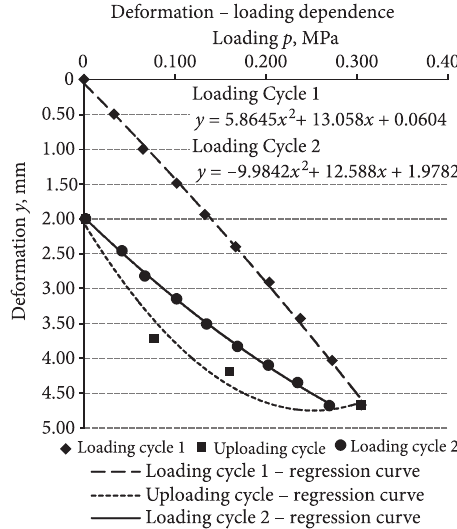
fig. 2. Record of the static plate loading